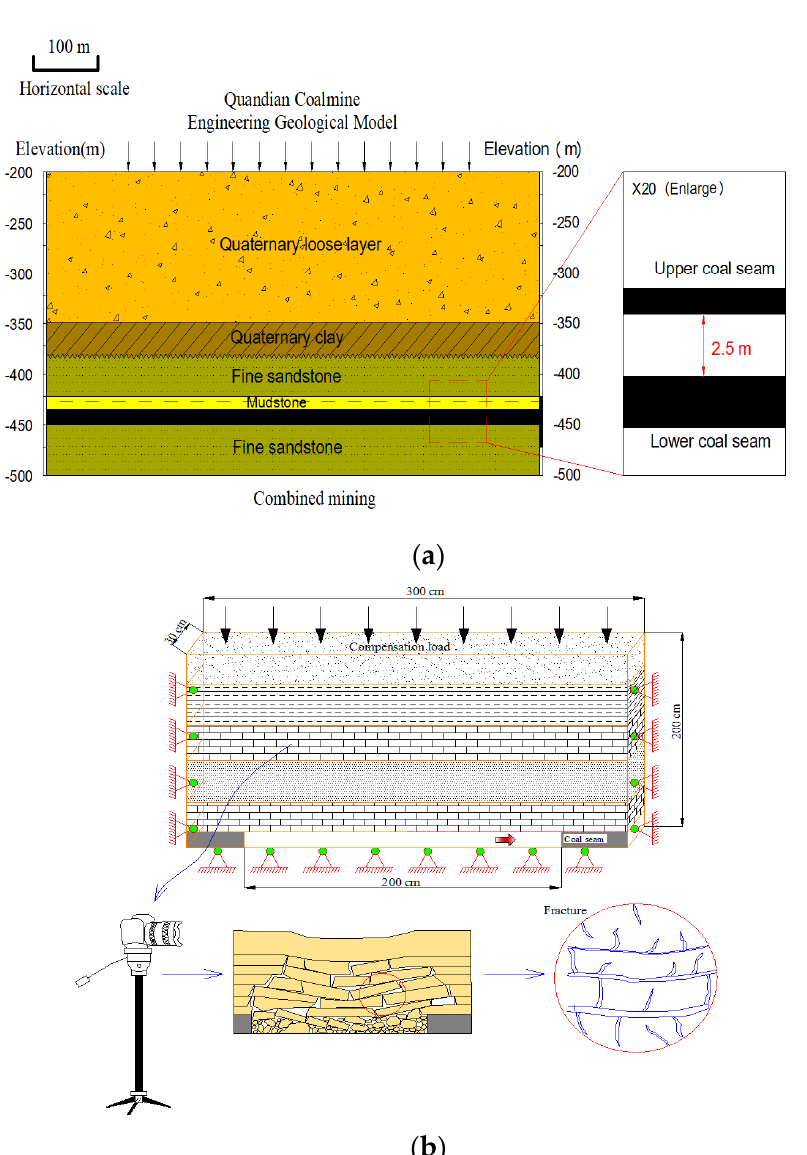
Figure 3. Plane-stress physical model of rock mass fractures: ( a ) Engineering geological model; ( b ) scale model. The coal seams in the mine were excavated by longwall caving. Then, images of the fractures were taken with a digital camera, and converted into binary images using a digital image processing program as shown in Figure 4. The RGB images were converted into greyscale images using the following formula: Greyscale = 0.4R + 0.4G + 0.2B (8) where the Greyscale level is the greyscale value of the image to be processed; and red (R), green (G), and blue (B) are the corresponding color values of each layer in the matrix of the original image. Then, the greyscale images were converted into binary images using threshold segmentation, and the changes in the fracture networks due to mining were obtained. In order to better illustrate the development of the fracture state due to mining, an 8 × 10 m mesh was divided to study the fractal dimension and fracture entropy, in addition to the relationship between the fractal dimension and fracture state in each mesh, as shown in Figure